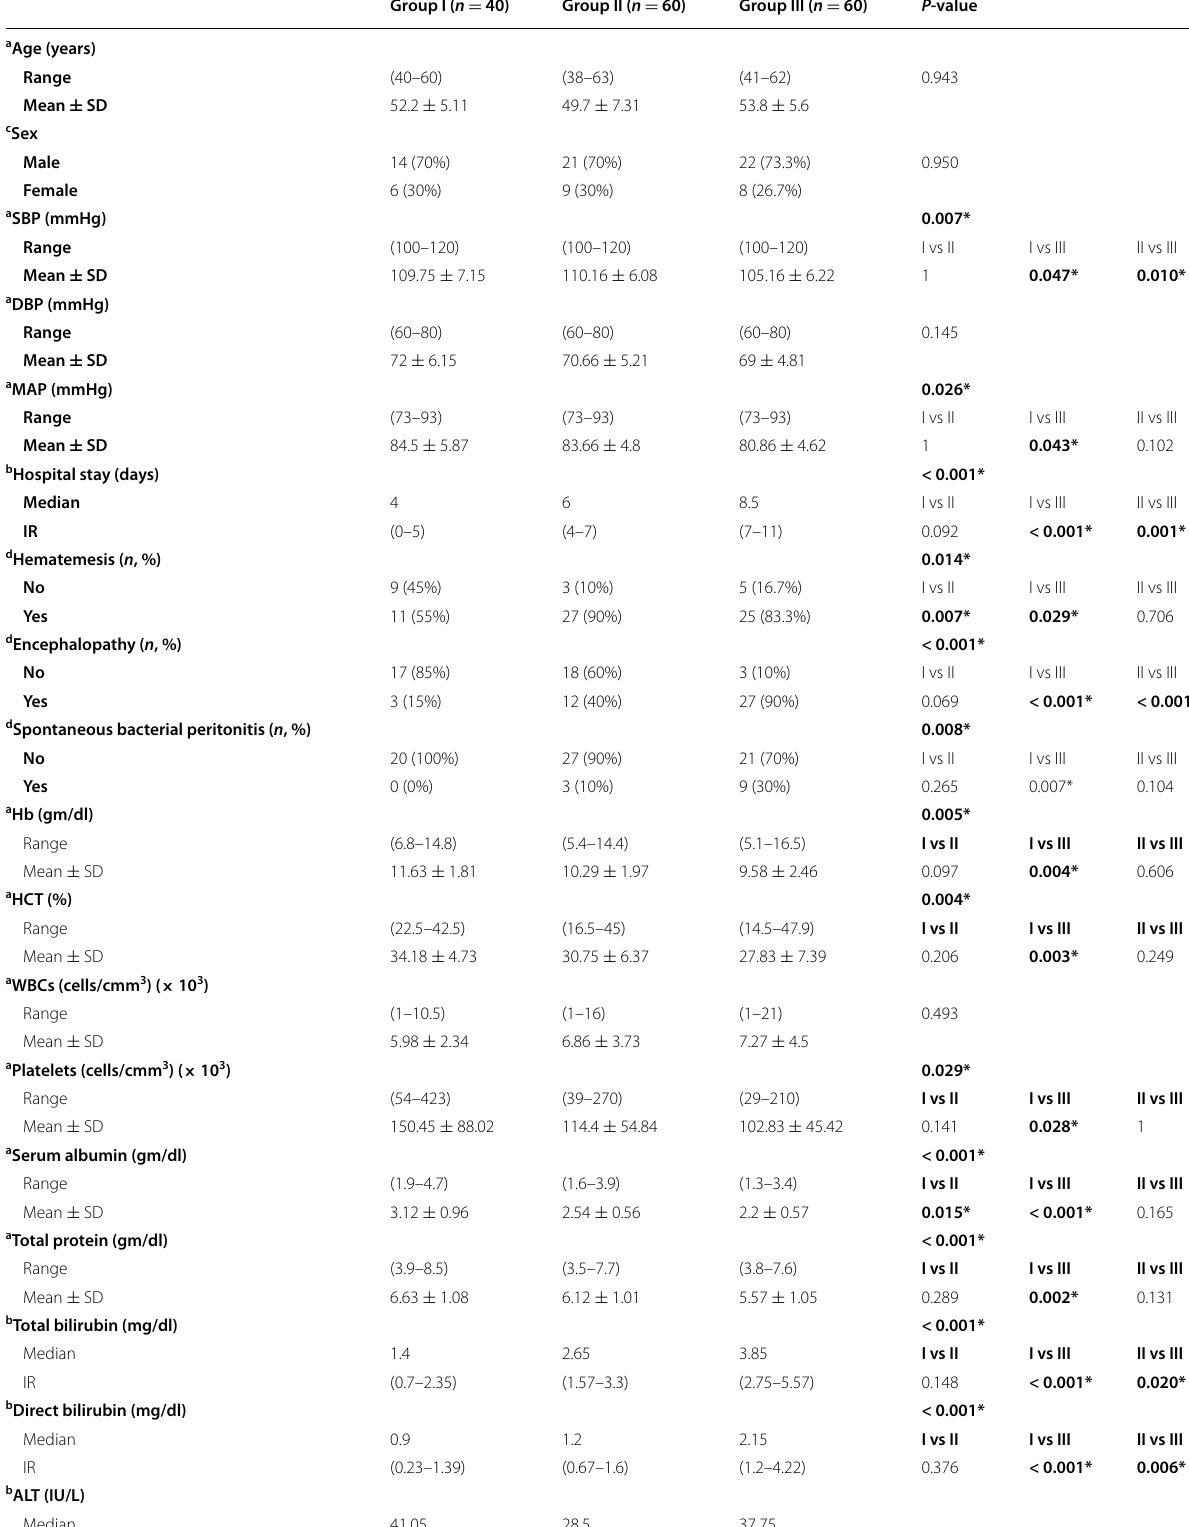
Table 1 Demographic, clinical, and laboratory characteristics of the study